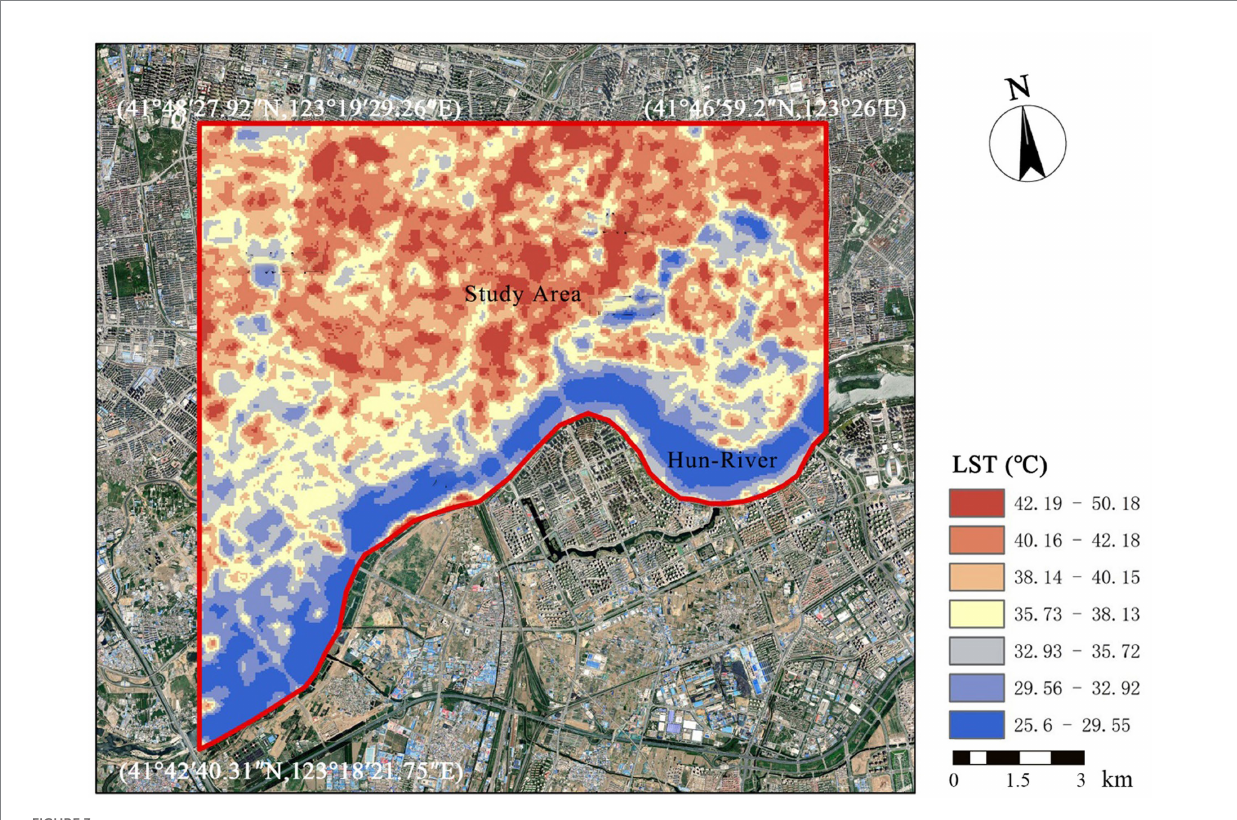
FIGURE 3 Land temperature distribution